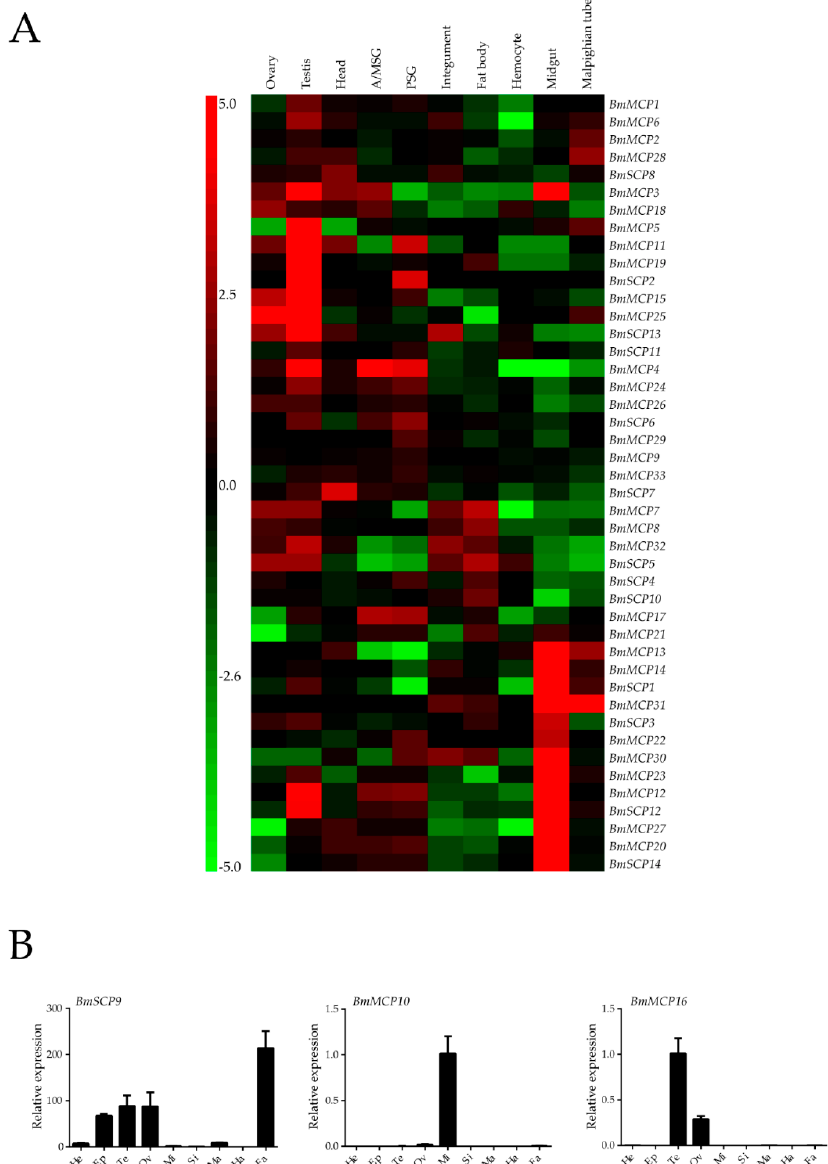
Figure 2. ( A ) Microarray analysis of carboxypeptidase expression in different silkworm tissues. Each column represents an organ or tissue, including testis, ovary, head, integument, fat body, midgut, hemocytes, Malpighian tubules, anterior/middle silk gland and posterior silk gland. Red represents high expression, and green represents low expression; ( B ) Expression patterns of the silkworm carboxypeptidases BmSCP9 , BmMCP10 and BmMCP16 . Abbreviations: He, head; Ep, epidermis; Te, testis; Ov, ovary; Mi, midgut; Si, silk gland; Ma, Malpighian tubules; Ha, hemocytes; Fa, fat body.